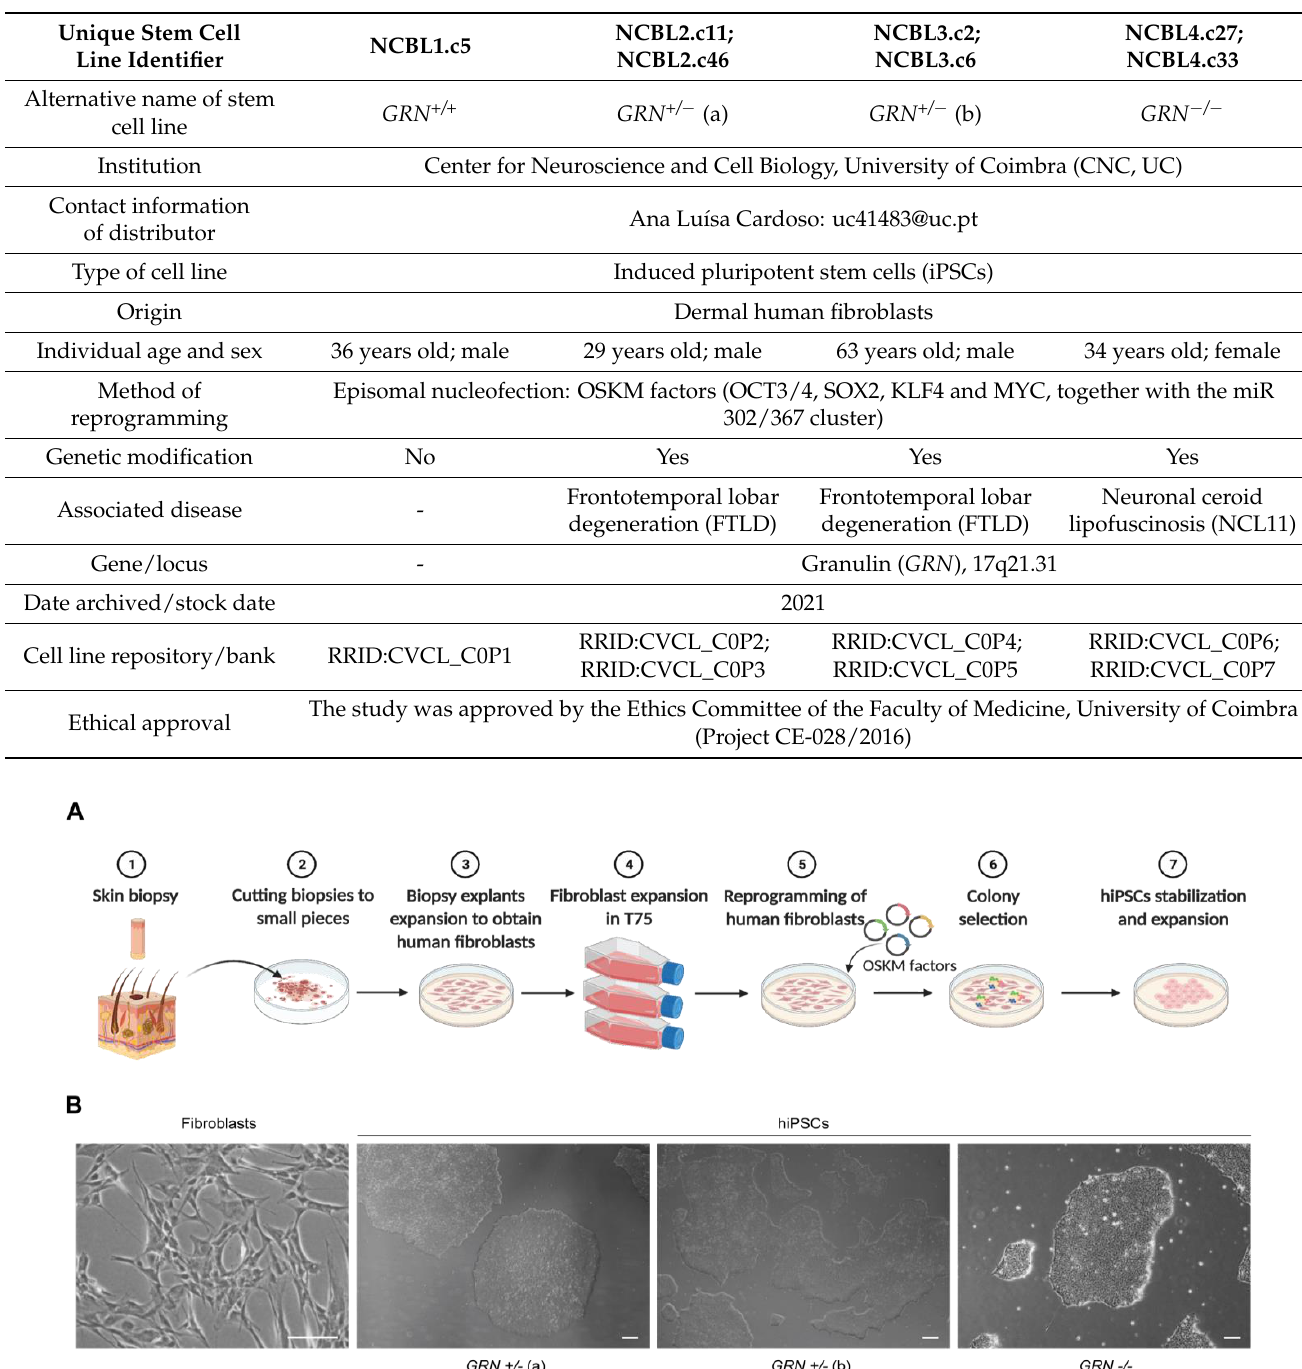
Table 1. General features of the newly generated cell lines.